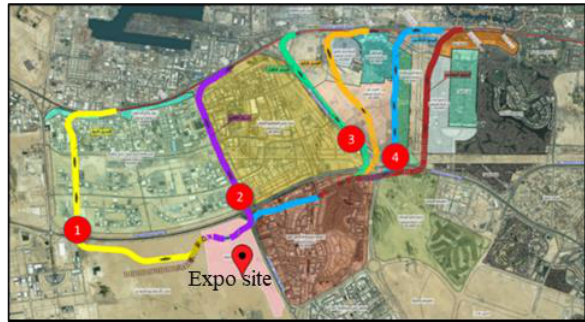
Figure 4 . Alignment options for Dubai metro route 2020 (Roads & Transport Authority Dubai, 2015)